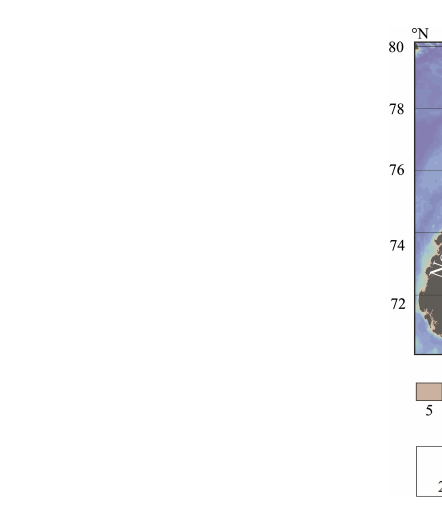
FIGURE 1 A map of the study area in the Kara Sea and locations of hydrographic stations on 25-26 October 2020 (green hexagons, transect T1), 24-28 October 2021 (black stars, transect T2), 21-26 October 2021 (red circles, transect T3), 13-15 October 2021 (blue triangles, transect T4), 19-20 October 2022 (brown squares, transect T5). The dashed black line indicates location of the Ob-Yenisei plume border during the periods of fi eld